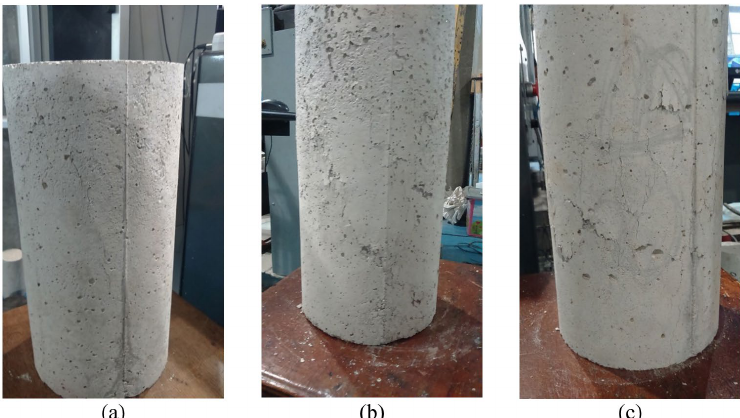
Figure 7. Examples of failure modes of reinforced concrete stub columns: a) CP1_30_2; b) CP1_90_3; c)